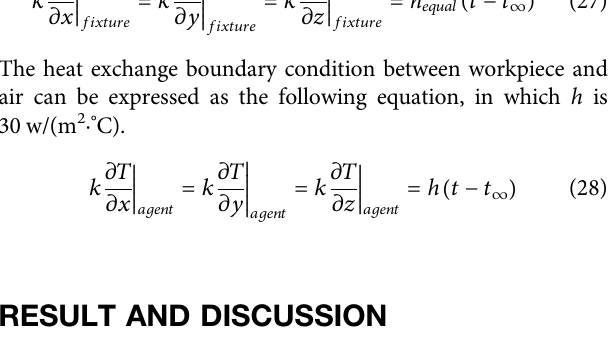
Frontiers in Materials |